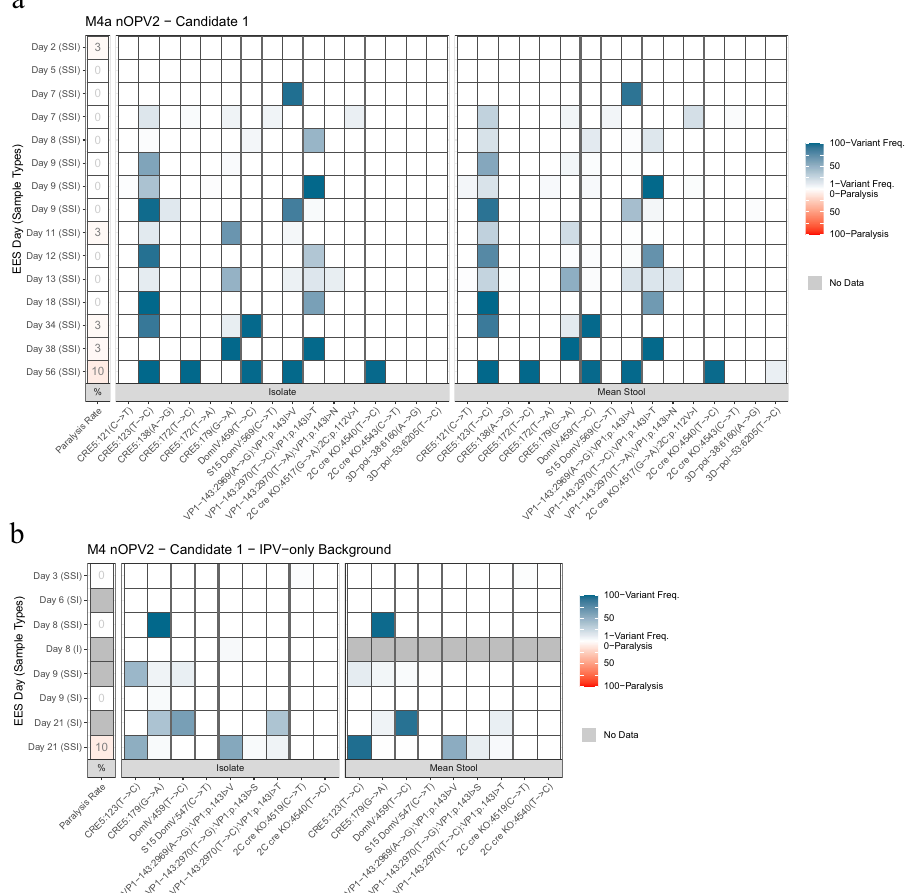
Fig. 5 nOPV2-c1. Frequency of variants in EES at known attenuation sites and mTgmNVT results. Participant vaccination history is IPV only. EES day shown with mTgmNVT result (red colour gradient) and variant frequency (blue colour gradient) averaged across two stool replicates (SS) and culture-ampli fi ed virus (I), if present. Amino acid associated with variant indicated, if applicable. S = Stool replicate; I = Culture- ampli fi ed virus isolate (SSI = Two stool replicates and culture-ampli fi ed virus isolate; SI = Single stool replicate and isolate). White cells = variant not detected. Grey cells = mTgmNVT result not available or no NGS data from stool (S)/culture-ampli fi ed virus (I). The NGS pipeline reports the variants as SNPs. Coding impact assumes changes are not in common genomes when multiple variants are observed in mOPV2 Phase 4 trial (M3). A subset of seven EES were selected for analysis prior to receipt of NGS results, with sub-sampling focusing more heavily on EES collected at earlier time points to attempt to have more diversity in the extent of reversion. All seven EES from individuals who received mOPV2 in the M3 trial showed high levels of paralysis in the mice, with paralysis rates ranging from 89% to 100% (Fig. 9a). Comparisons between paralysis rate and levels of A481G and VP1-143 mutations are shown in Fig. 4 and Supplementary Table 3 with the presence of A481G at high levels associated with high paralysis rates; effect, if any, of VP1-143 variants was not observed. In comparison, the mOPV2 vaccine lot administered also was tested at the same dose over several runs, with 0/50 mice paralyzed. Shed nOPV2-c1 virus from phase 1 and 2 trials